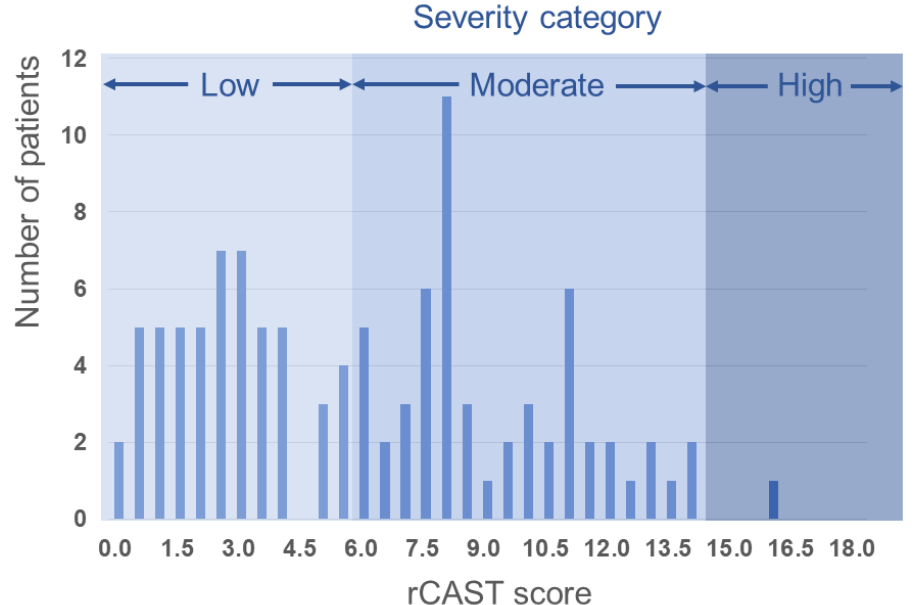
Figure 2. The distribution of the rCAST score and the three severity categories.